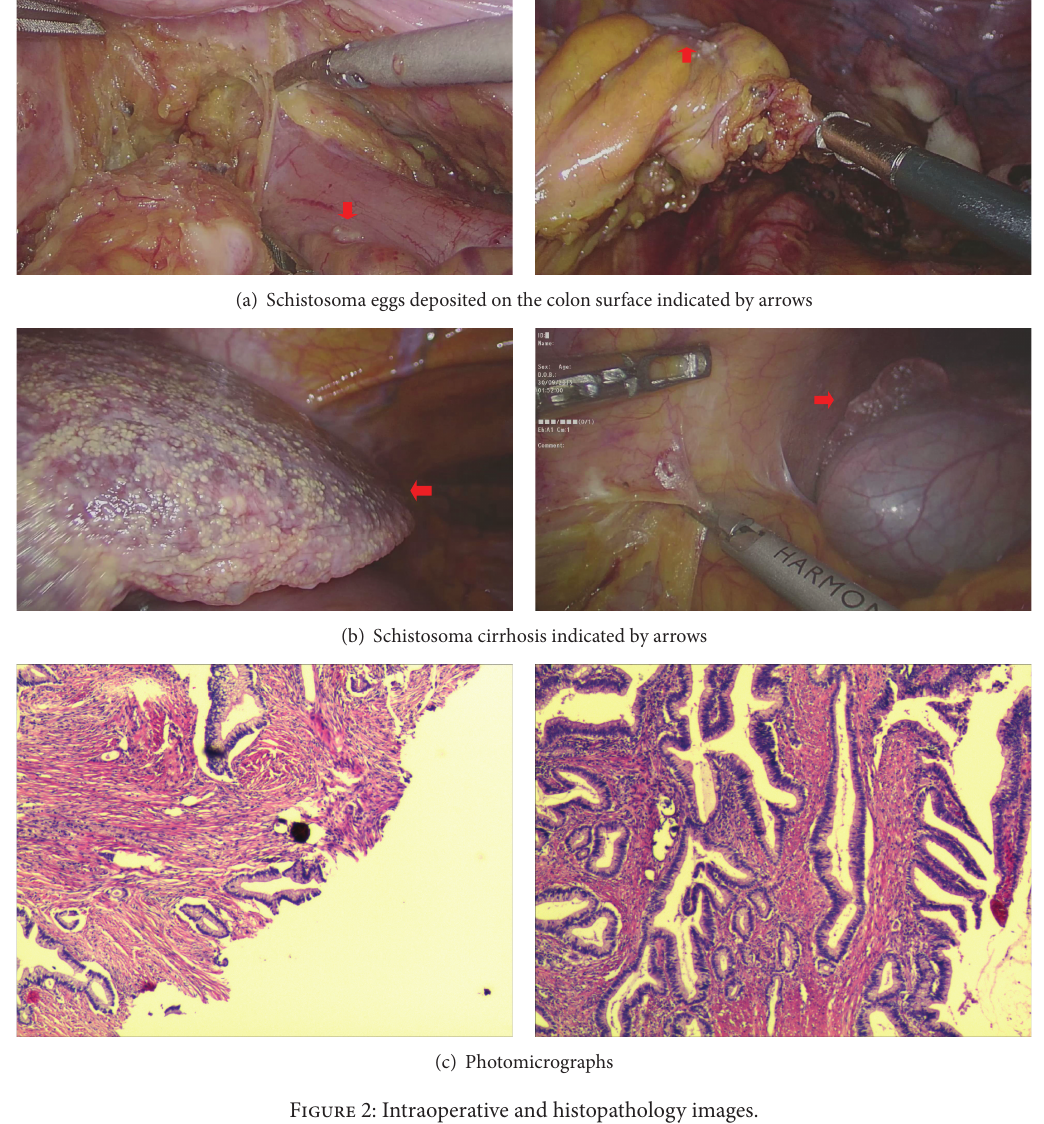
Figure 2: Intraoperative and histopathology